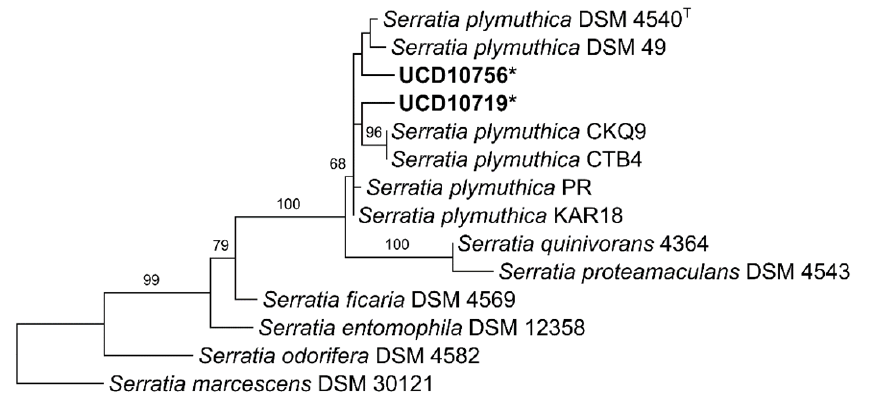
Figure 4. Most parsimonious phylogenetic analysis of two isolates of Serratia plymuthica obtained from commercial grapevines in California compared to closely related species. The tree was inferred with sequences of 16S rDNA gene. Numbers above branches represent non-parametric bootstrap values from 1000 replicates. S. marcescens (DSM 30121) was used as outgroup. T = type strain of S. plymuthica (DSM 4540 = K − 7). * = isolates used in dual antagonism assays and metabolites analyses.